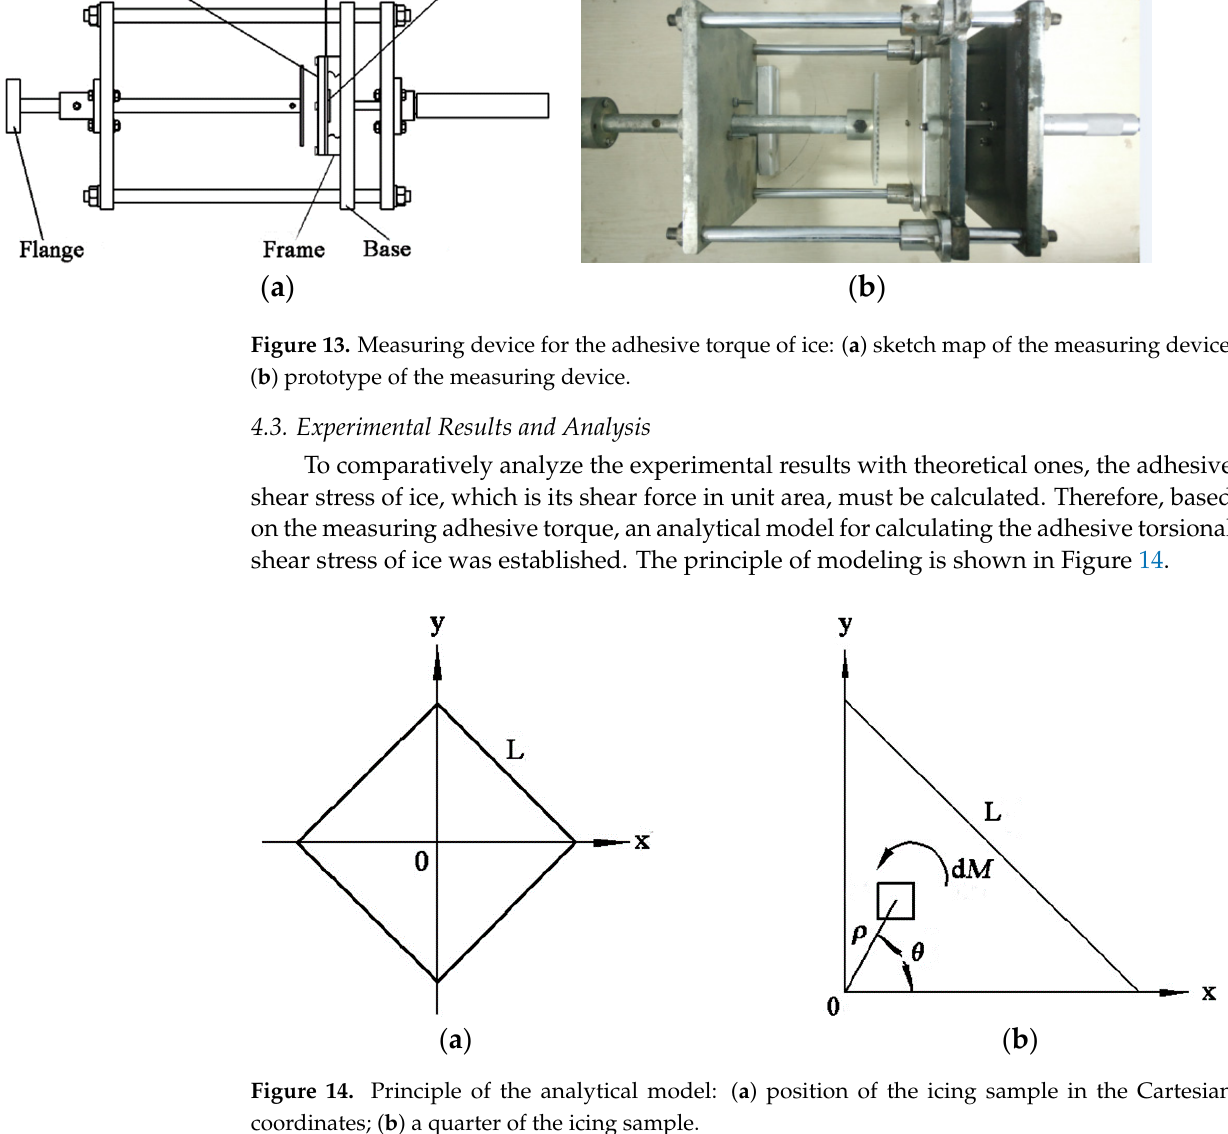
Figure 13. Measuring device for the adhesive torque of ice: ( a ) sketch map of the measuring device; ( b ) prototype of the measuring device.